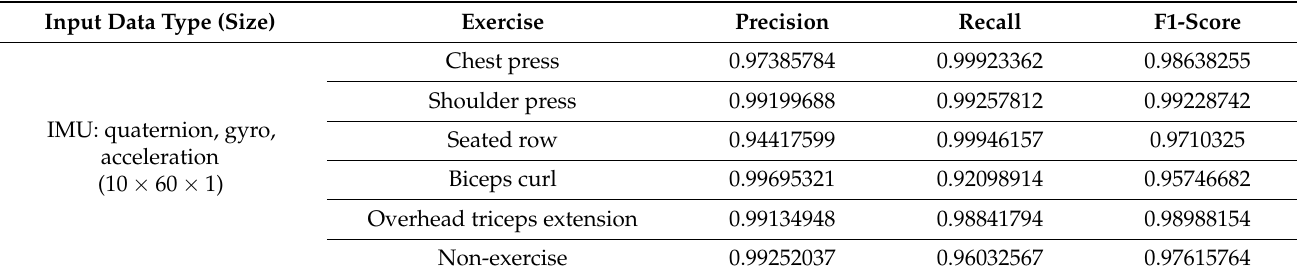
Table 6. Precision, recall, and F1-scores of the IMU input model.